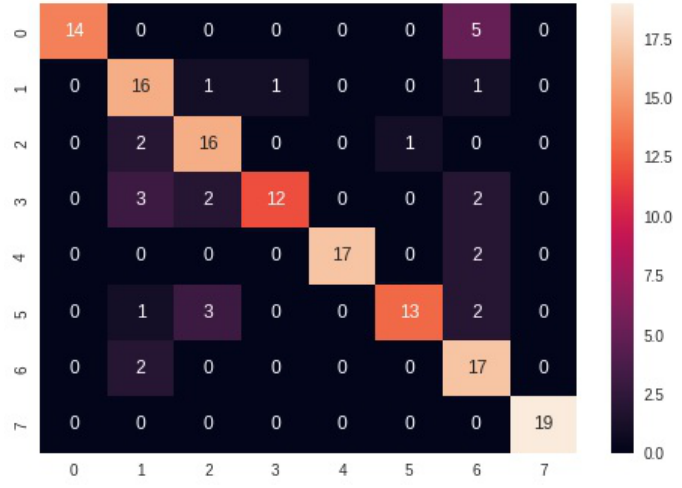
Figure 7. kNN-based confusion matrix.